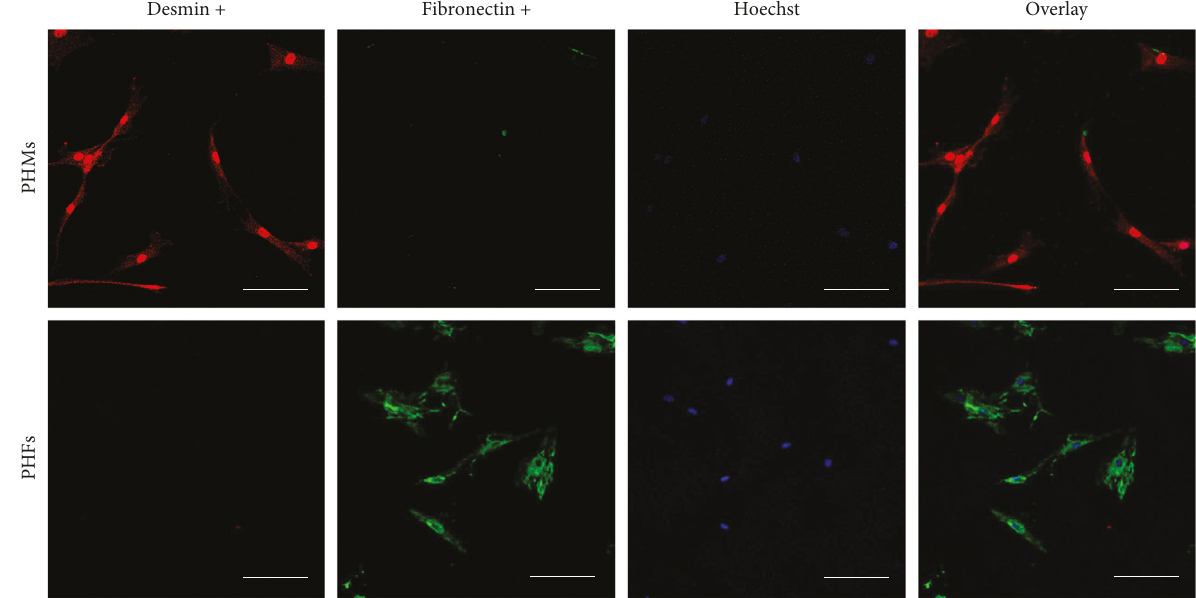
Figure 1: Cell type confirmation of primary human myoblasts (PHMs) and fibroblasts (PHFs) staining with desmin (red) and fibronectin (green), respectively. Nuclei are visualised using Hoechst (blue). Images were captured at 200x magnification. The scale bar represents 100 μ